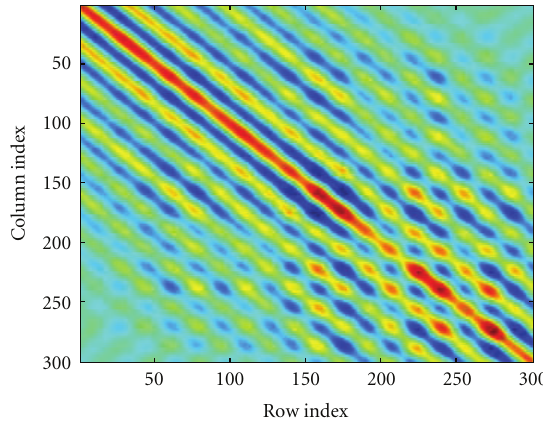
Figure 5: Residual matrix A = S T S , where S is the data residual corresponding to the smooth model depicted in Figure 1(a) at